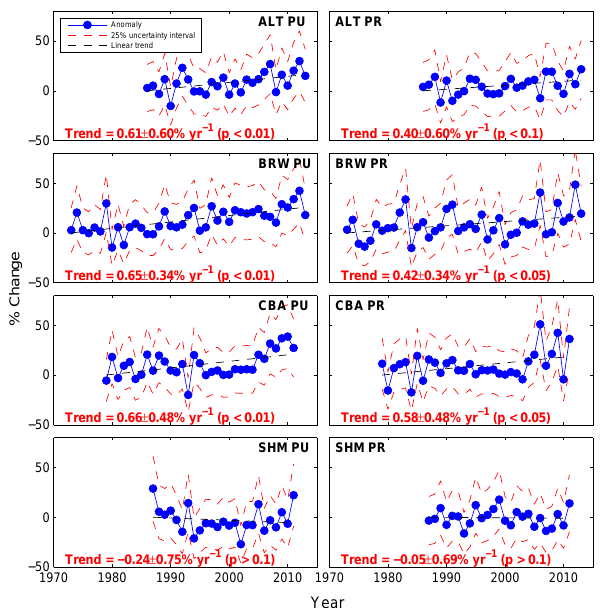
Figure 8. Time series of the percentage change of peak uptake and release at four high northern latitude sites (see main text). Each panel shows the data as blue closed circles and the 25% uncertainty interval. The dashed black line is the fitted linear trend that is re- ported inset of each